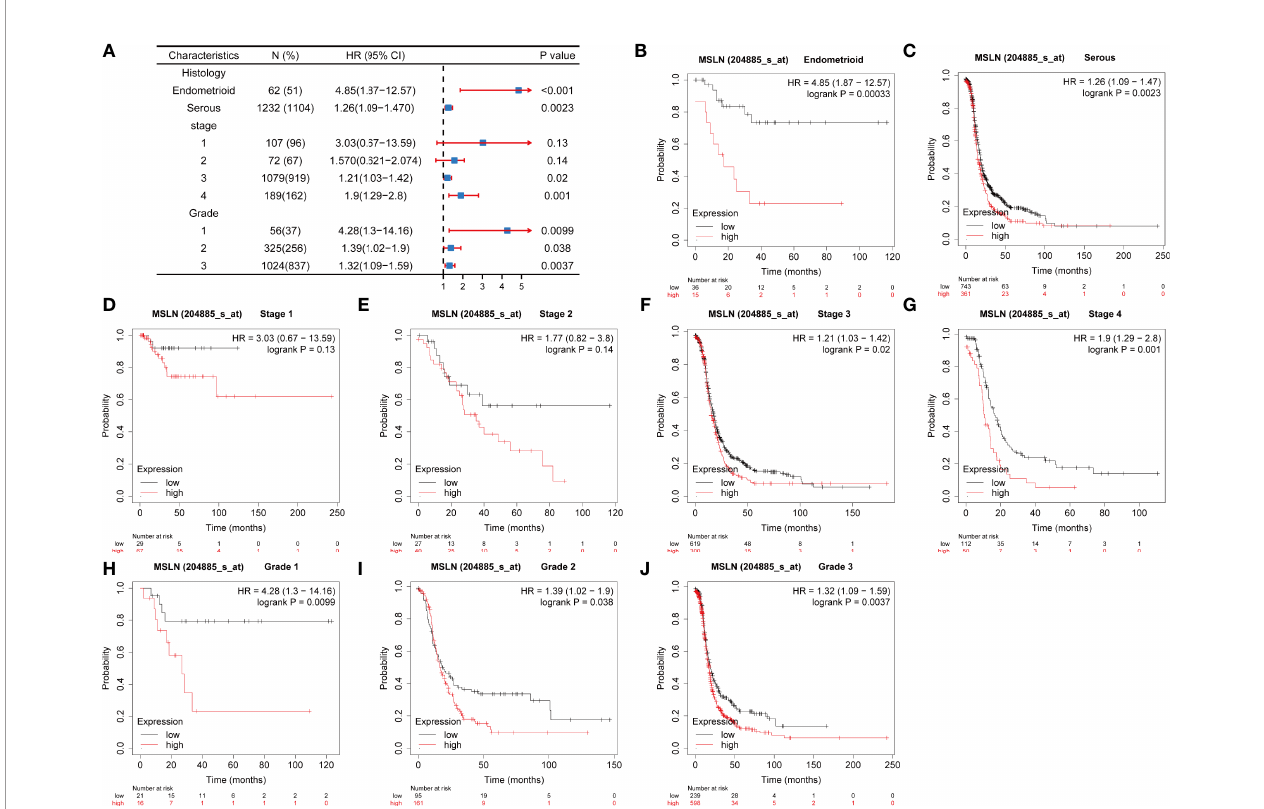
FIGURE 3 | Association between MSLN expression and prognosis of ovarian cancer. (A) Correlations between the expression of MSLN and the overall survival rate in different stages of ovarian cancer. (B, C) Kaplan-Meier analysis of the relationship between MSLN and overall survival rate of ovarian cancer at different histological levels in TCGA. (D – G) Kaplan-Meier analysis of the relationship between MSLN and overall survival at different stages of ovarian cancer in TCGA. (H – J) Kaplan-Meier analysis of the relationship between MSLN and overall survival at different grades of ovarian cancer in